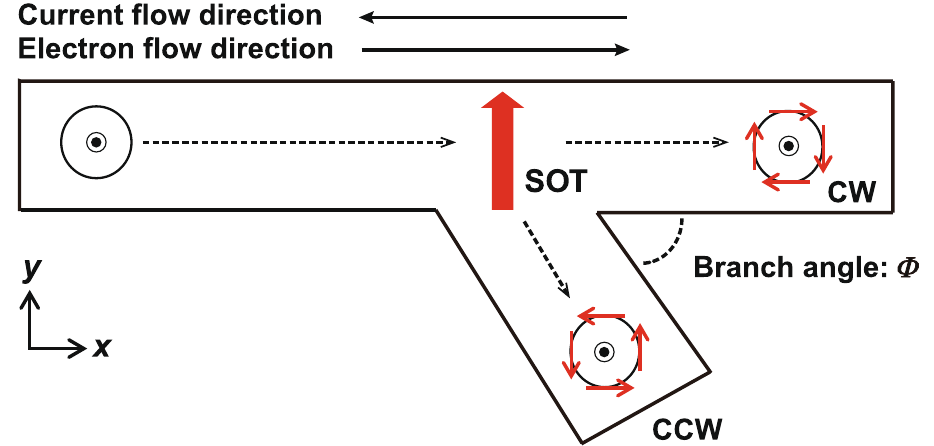
Figure 2. Illustration of a nanowire with a branch to discriminate a skyrmion chirality.